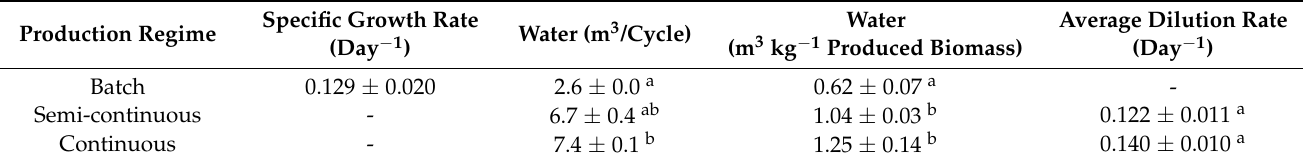
Table 1. Specific growth rate, average dilution rate and amount of water spent, either per cycle or per amount of produced biomass, in the growth of Nannochloropsis oceanica in 2.6 m 3 tubular PBRs, in three different operation regimes. The values represent the average and standard deviation of three biologically independent replicates. Different letters within the same column represent significantly different values ( p -value < 0.05).